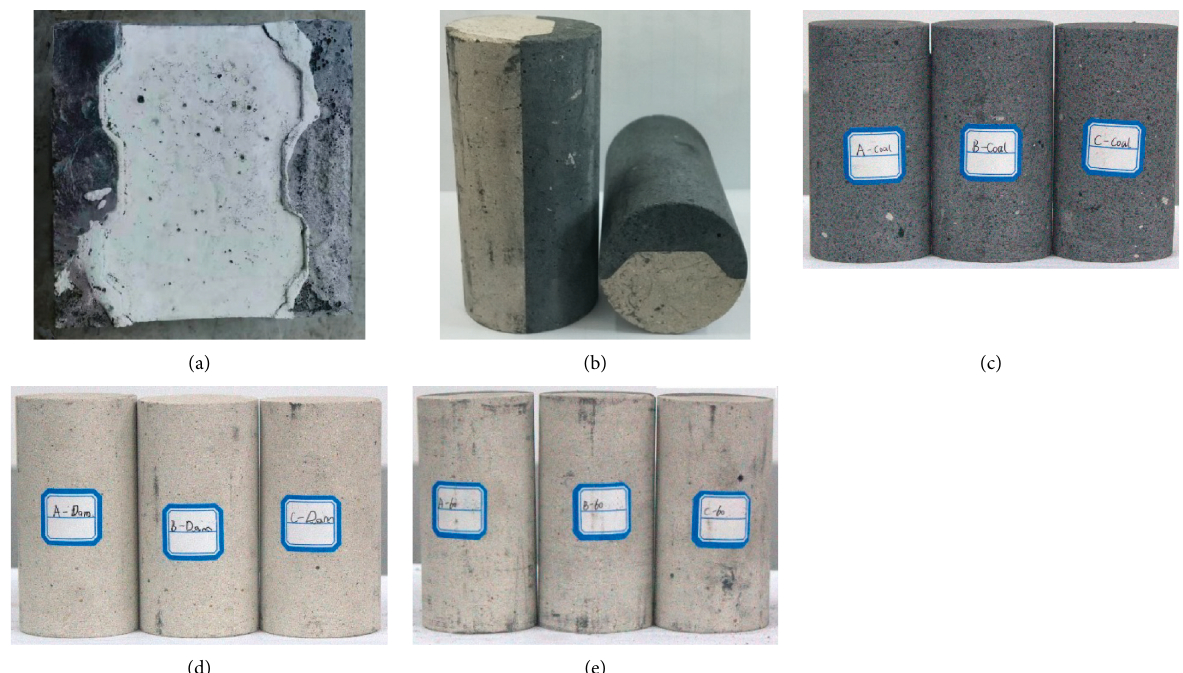
Figure 5: Coal pillars-artificial dam samples. (a) Cube test block, (b) core drilling of test piece (c) coal pillar samples, (d) artificial dam samples, and (e) coal pillars-artificial samples.